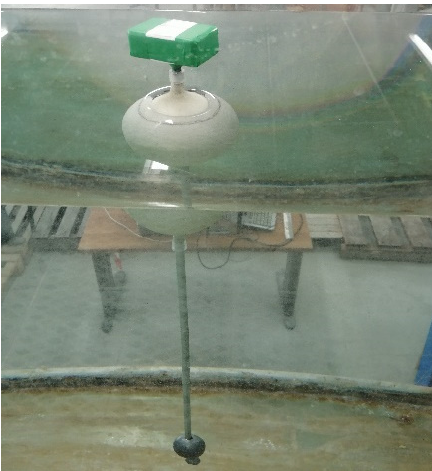
Figure 6. Spar buoy scaled model during test.